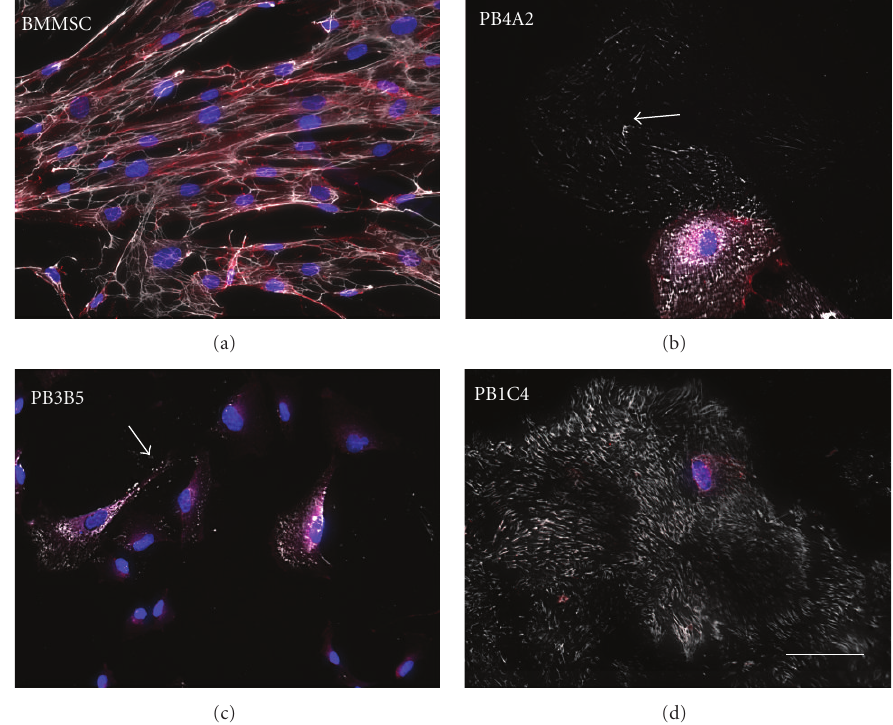
Figure 6: Immunostaining of fibronectin and N-cadherin. BMMSCp5, PB4A2p16, PB3B5p11, and PB1C4p12 cell populations were immunostained for fibronectin (grayscale), N-cadherin (red), and fluorescent chromatin dye (blue). Scale bar, 50 microns, is identical in all